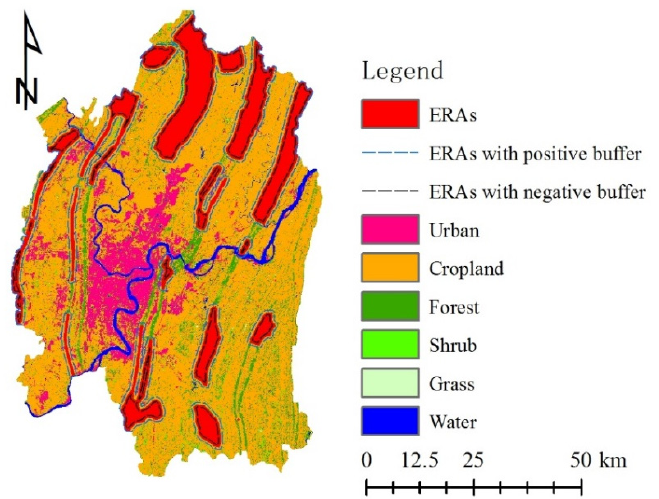
Figure 6. Eco-redline areas (ERAs) and the assumed expansion and shrinkage of them represented by using positive and negative buffers (LULC 2010 as background). Table 9. Constraint coefficients under different management intensities.